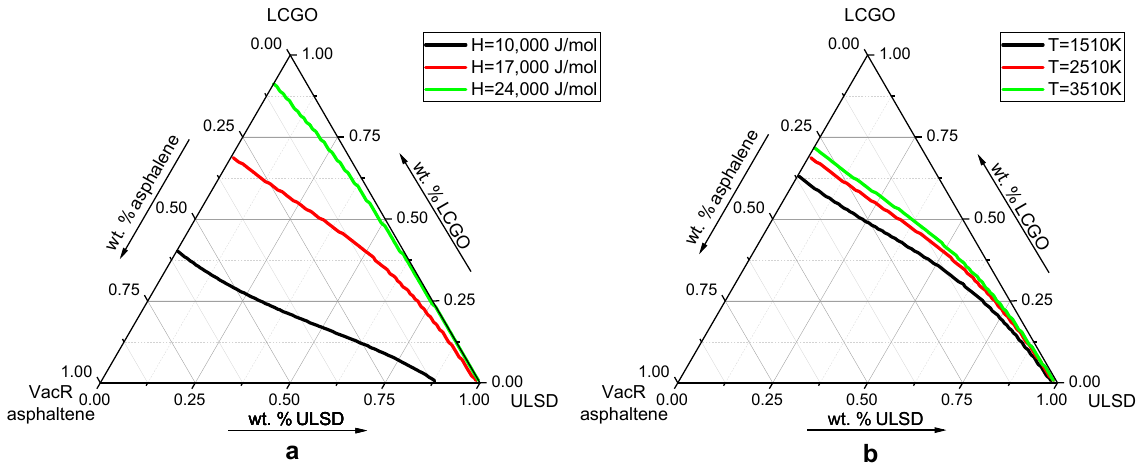
Figure 2. Asphaltene solubility at various parameters (composition is indicated in mass fractions): ( a ) melting heats; ( b ) melting temperatures. Hereinafter, the asphaltene solubility isotherm VacR at 298 K and other characteristics presented in Table 2 are taken as a comparison system. Here, γ add is the activity coefficient multiplier showing the effect of the melting process on the chemical potential of asphaltene. The contribution of RTln γ add at an experimental temperature of 400 K, asphaltene melting point of 1500 K, value of Δ T = 1100 K, and heat of fusion of 10,000 J/mol will be 12,500 J/mol. For the quantity γ add the value equal to 7.4 is obtained. With an increase in the heat of fusion by 1.5 times, the contribution will increase to the power of 3/2 and will be 20.12. On the other hand, the influence of the melting temperature of asphaltene is in- significant which follows from the same formula. Indeed, by increasing Т 0 to 2500 K, Δ Т is simultaneously increased to 2100 K. The Δ Т / Т 0 ratio changes from 11/15 to 21/25, so it is increased by only 10%. Thereafter, γ add will also increase by only 10%. The effect of variations in the asphaltene structure on the solubility curve also turned out to be insignificant. However, the structure varied in the range of py- rene-ovalene k values. It was considered that the polyaromatic frame of the studied as- phaltene is similar to either pyrene or ovalene in terms of the ratio of carbon atoms with hydrogen to carbon atoms without hydrogen (N ACH /N AC ). For pyrene ( С 16 Н 10 ), it is 10/6, and for ovalene ( С 32 Н 14 ), it is 14/18. For more complex structures, a more noticeable effect is also possible. The calculation results are shown in Figure 3a.